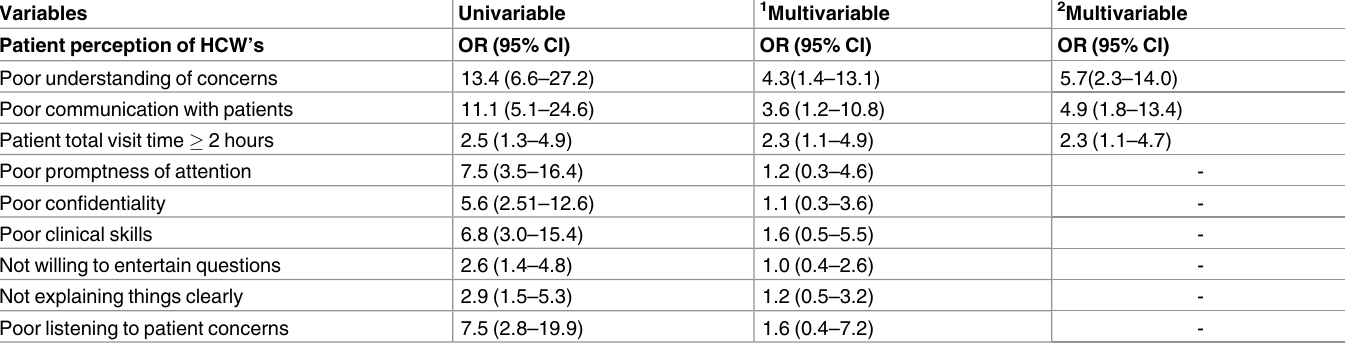
Table 3. Odds ratios and 95% confidence intervals of dissatisfaction with the PMTCT servicesaccording to the patient’s perception of care received. Variables